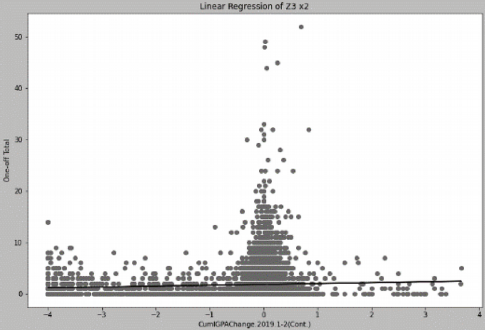
Figure 6. Linear Regression of Z3 x2 in Finding 1